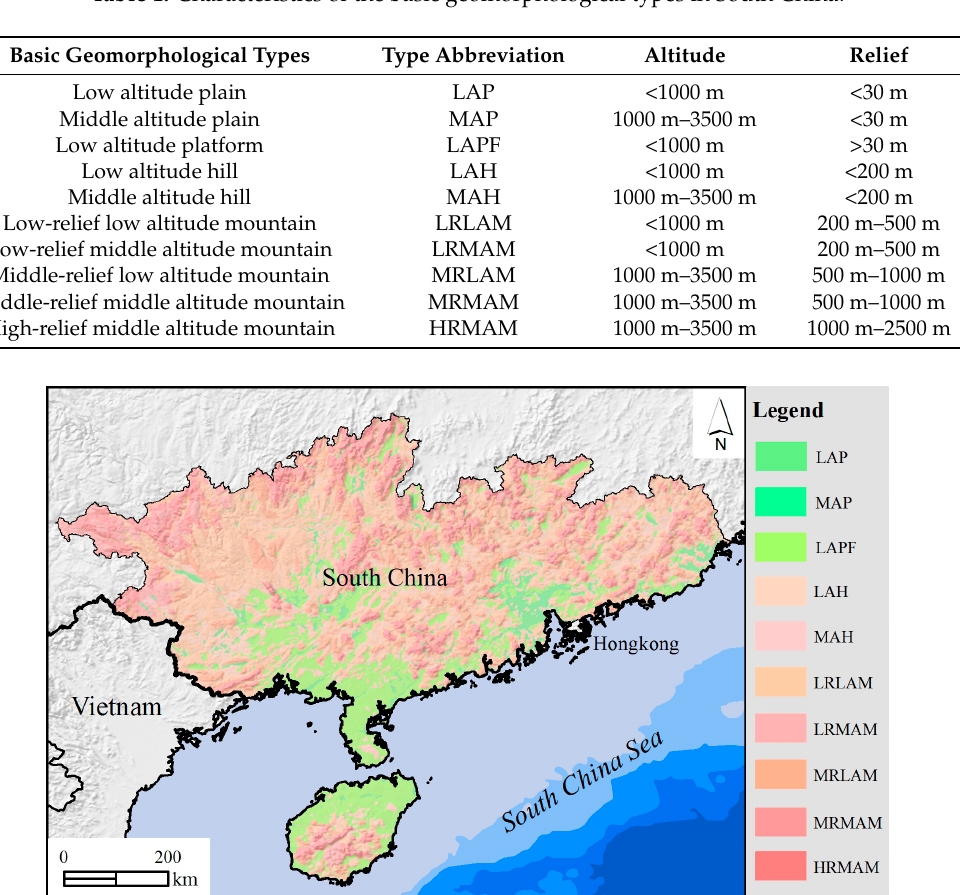
Table 1. Characteristics of the basic geomorphological types in South China.